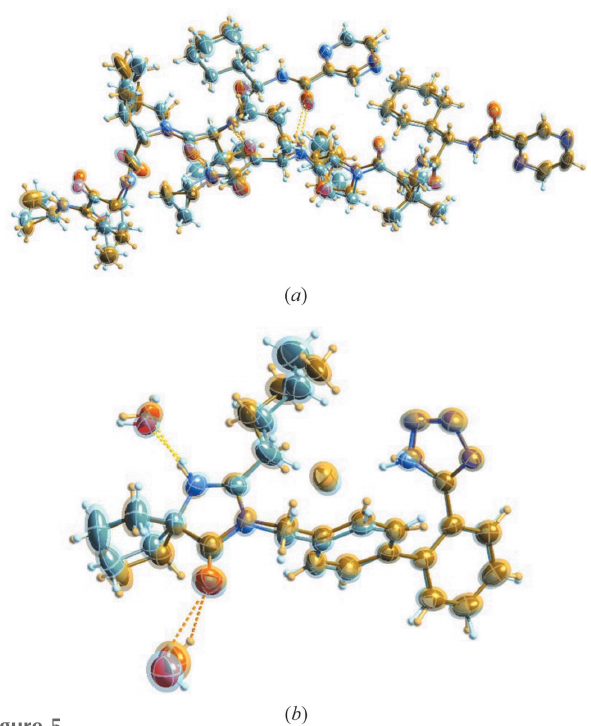
Figure 5 Displacement ellipsoid representations of the structures of telaprevir [CSD refcode LERJID, ( a )] and irbesartan bromide sesquihydrate [CSD refcode NIQVIT, ( b )]. For molecules the size of LERJID, finding the overlaying atoms and assigning EADP constraints can be facilitated by suitable software. The illustrations were generated with SHELXLE (Hu¨bschle et al. , 2011) using the restrained (DFIX/DANG) and constrained (EADP) refinements I